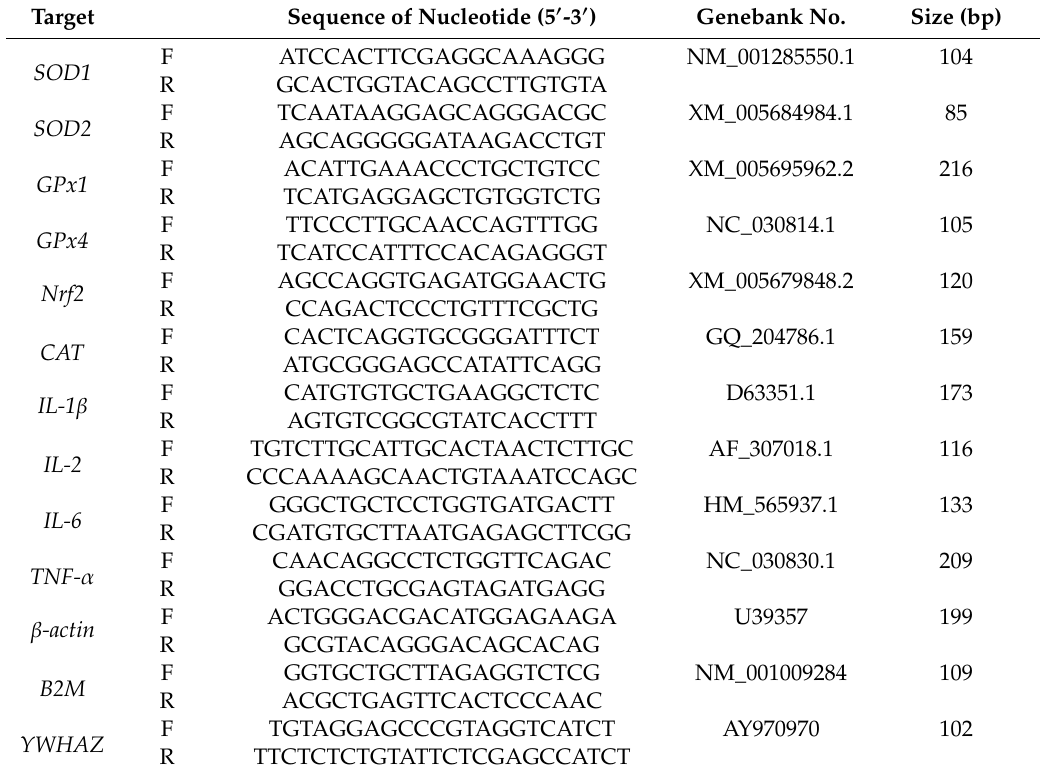
Table 1. Primers for quantitative real-time